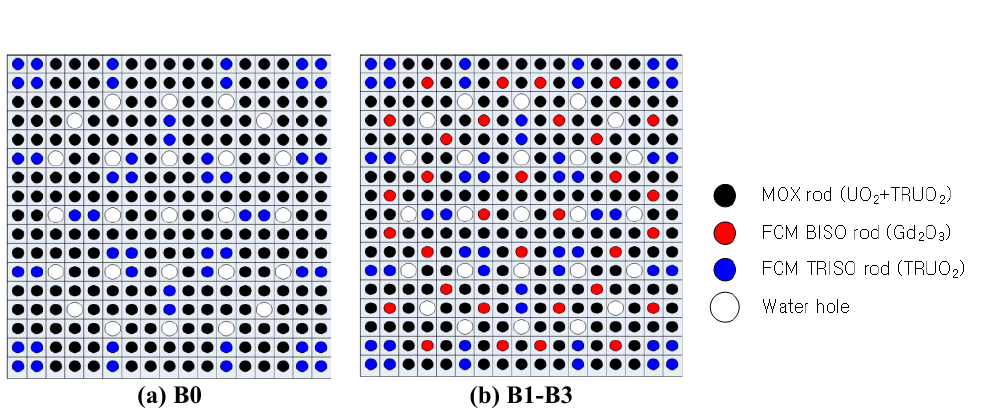
Figure 1. Configuration of the 17×17 fuel assemblies composed of MOX rods and FCM rods ) calculated by DeCART2D and Figure 2 compares the evolutions of the infinite multiplication factors (k inf values calculated by McCARD are McCARD for each fuel assembly. As shown in the figure, all the k inf estimated to be large than those of DeCART2D at BOC. The differences of the reactivity at BOC between DeCART2D and McCARD were 338 pcm, 366 pcm, 378 pcm and 610 pcm for B0, B1, B2 and B3 fuel assemblies, respectively. That is, the reactivity difference at BOC increases as the amount of burnable values calculated by DeCART2D and McCARD shows a absorber increases. The comparison of the k inf good agreement each other throughout all the burnup steps.